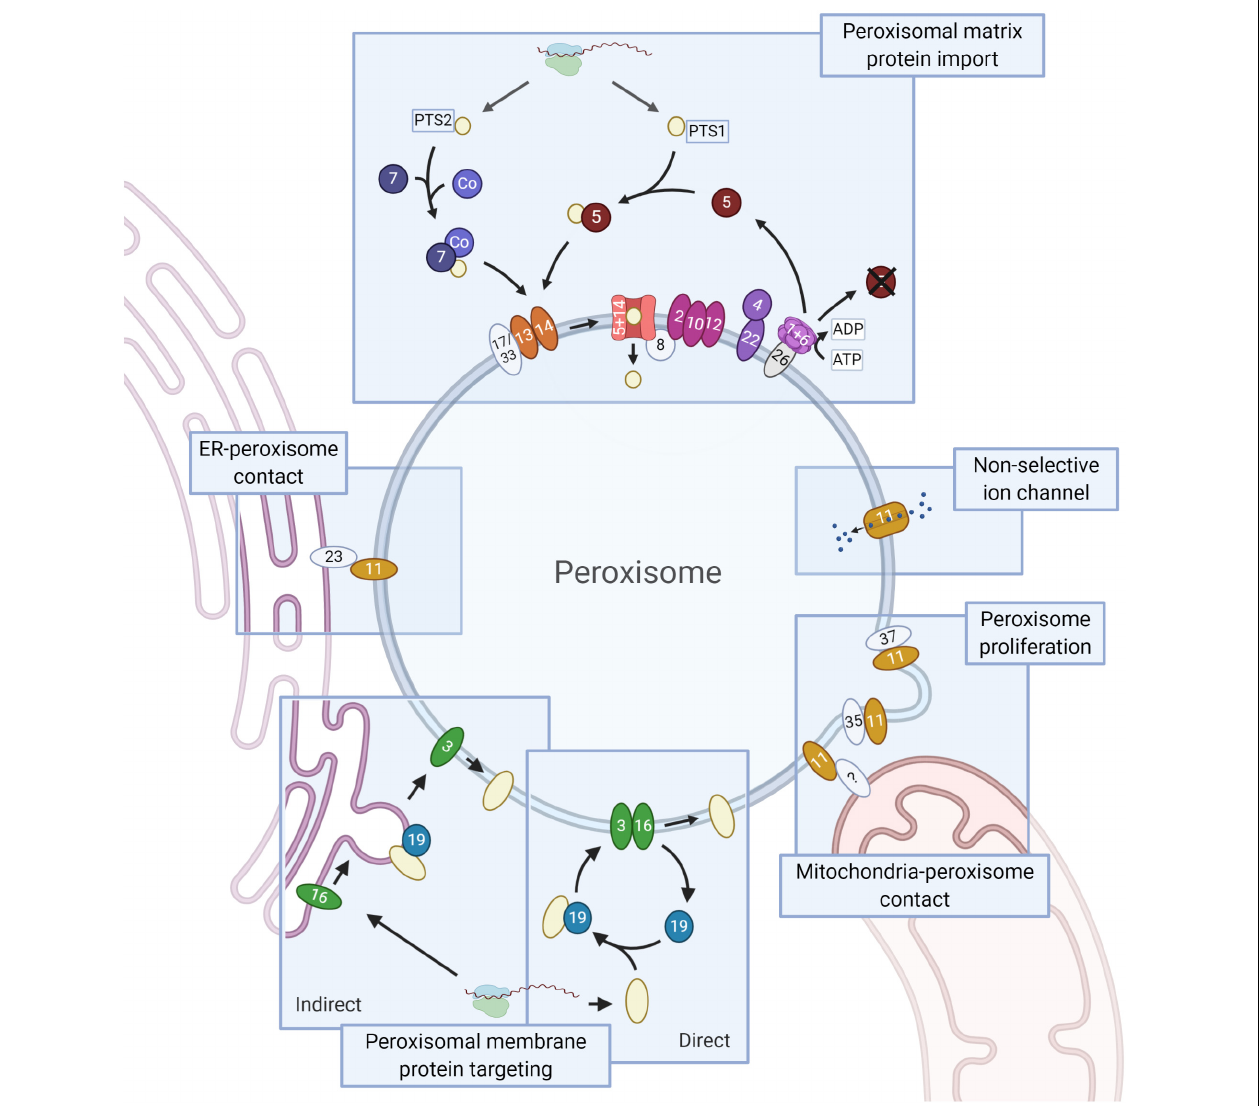
FIGURE 1 | Schematic representation of the PEX proteins. Core conserved PEX proteins (shapes in dark colors, names in white), fungi-specific proteins (light, names in black) and the moderately conserved PEX protein PEX26 (gray, name in black, which is only present in Metazoa and Fungi) are depicted. Membrane proteins are ovals, soluble proteins round. Matrix protein import. Peroxisomal matrix proteins contain a peroxisomal targeting signal (PTS) that is recognized by cytosolic receptors: a C-terminal PTS1 or (less commonly) an N-terminal PTS2, recognized by PEX5 and PEX7, respectively. PTS2 import involves a co-receptor (Co): PEX5 (animals, plants, and protists), PEX18/21 ( S. cerevisiae ) or PEX20 (Fungi). Next, the receptor-cargo complex associates with the docking complex, consisting of PEX13/14 (and in Fungi PEX17 or PEX33). Upon cargo translocation and release, the PTS (co-)receptor is ubiquitinated and recycled. Ubiquitination involves the ubiquitin conjugating enzyme (E2) PEX4 (recruited to the membrane by PEX22) and the ubiquitin ligase (E3) activities of the RING finger complex, consisting of PEX2/10/12. Receptor extraction requires the AAA+ ATPase complex PEX1/6, which is recruited to the membrane via PEX26 (PEX15 in S. cerevisiae, APEM9 in plants – only PEX26 shown). PEX8 links the docking and RING finger complexes, and functions in receptor-cargo dissociation. Peroxisomal membrane protein (PMP) targeting involves PEX3, PEX19 and PEX16. PMPs can sort directly to peroxisomes or indirectly via the ER. In the direct pathway PEX19 acts as receptor/chaperone, while it functions at the ER in PMP sorting via the indirect pathway. The Pex11 protein family (all show as PEX11) and the fungal peroxins PEX35 and PEX37 have been mainly implicated in peroxisome proliferation. Pex11 family proteins are also present in mitochondria-peroxisome contact sites and PEX11 functions as non-selective ion channel. Members of the fungal Pex23 protein family localize to the ER and are involved in the formation of peroxisome-ER membrane contact sites. Created with